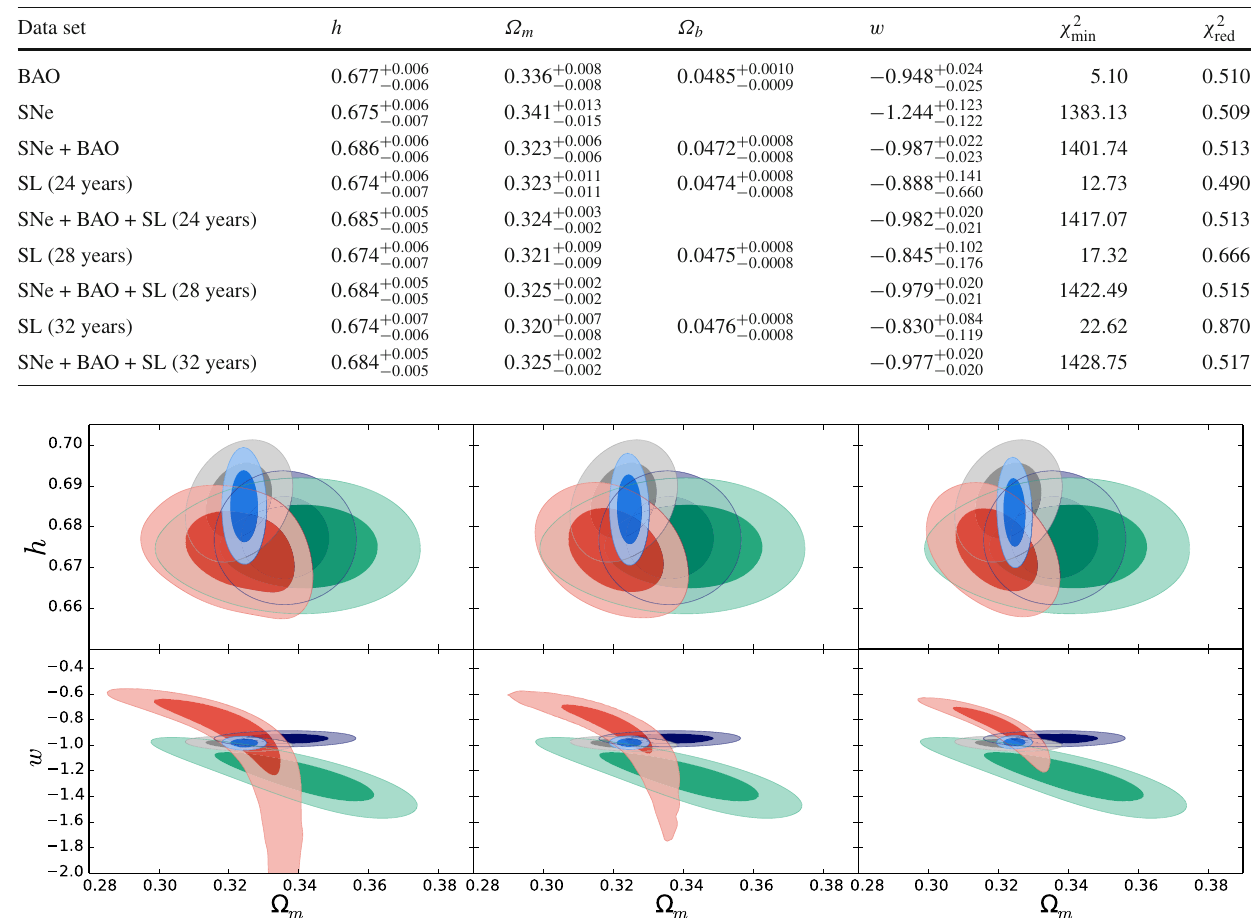
Table 3 Parameter results of the quiessence model